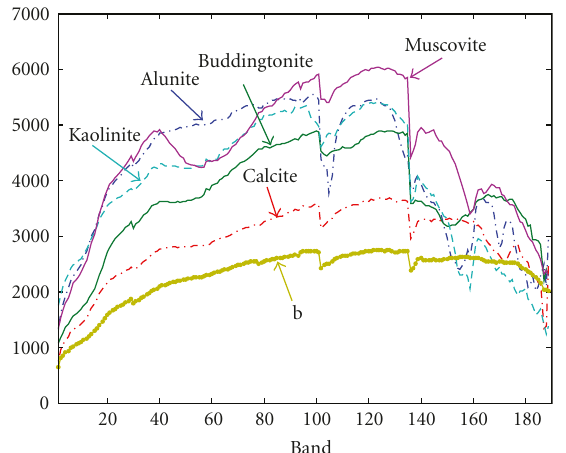
Figure 2: Five mineral reflectance spectra and BKG signature— which is the average of area BKG in the top right of Figure 1(a).